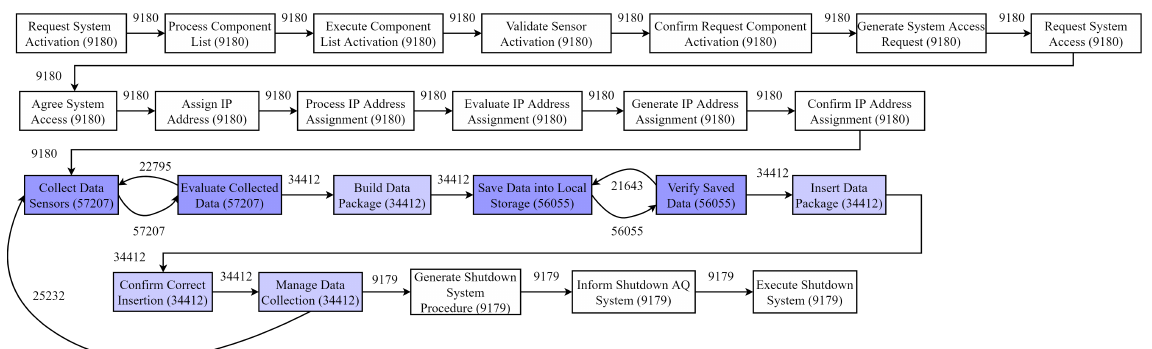
Figure 4. Frequency of each activity contained in the event logs.